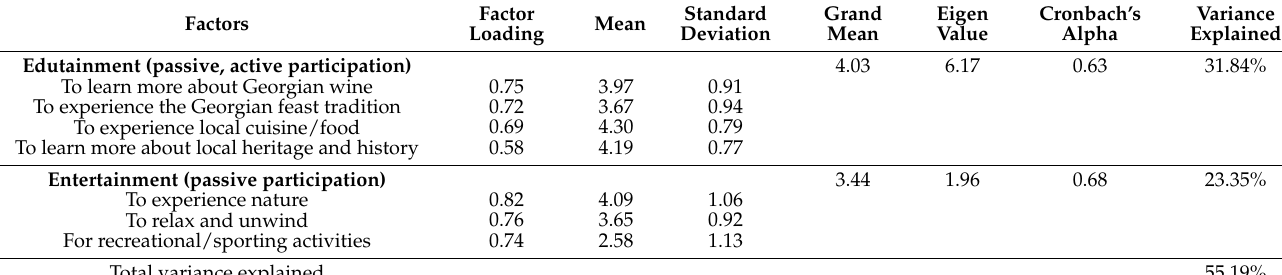
Table 3. Results of the factor analysis for the motivation to visit